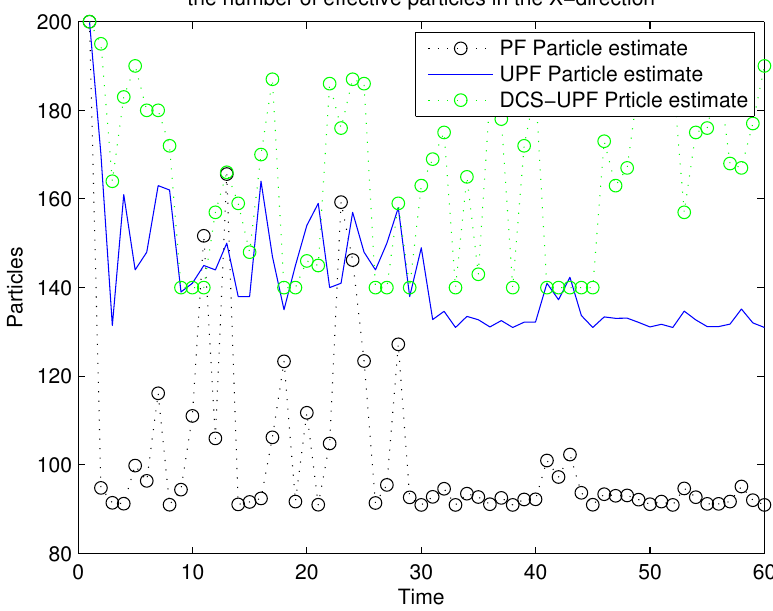
Figure 11. The effective particles numbers of three filters in X-direction.